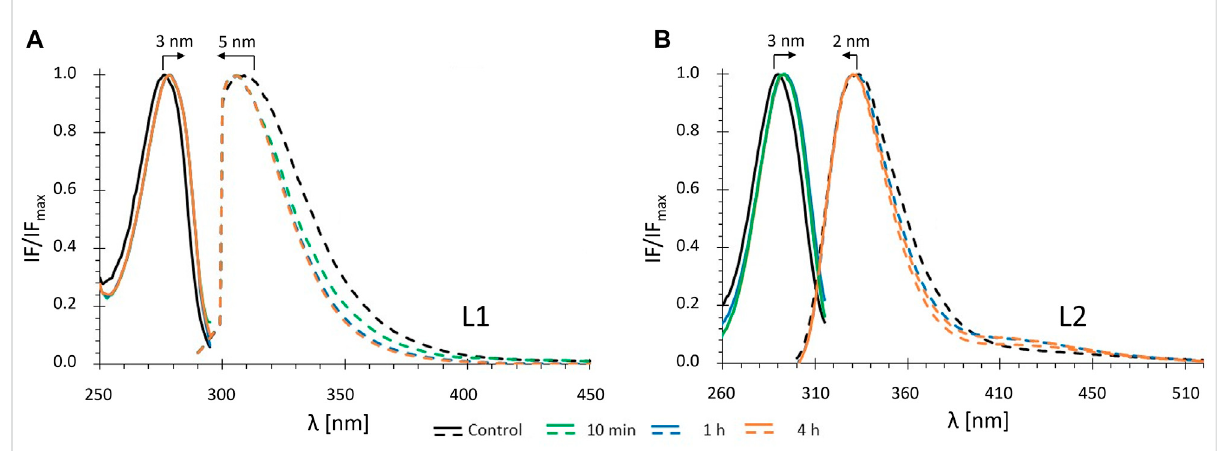
FIGURE 3 Fluorescence spectra of ligands L1 (A) and L2 (B) in buffer 1 : normalized excitation (solid lines) and emission spectra (dashed lines) in the absence(control:black)andinthepresenceofDOPCLUVs([DOPC]=1.0 mM)fordifferentincubationtimes:green-10min;blue-1h;orange-4 h (c L1 = 20 μ M; c L2 = 15